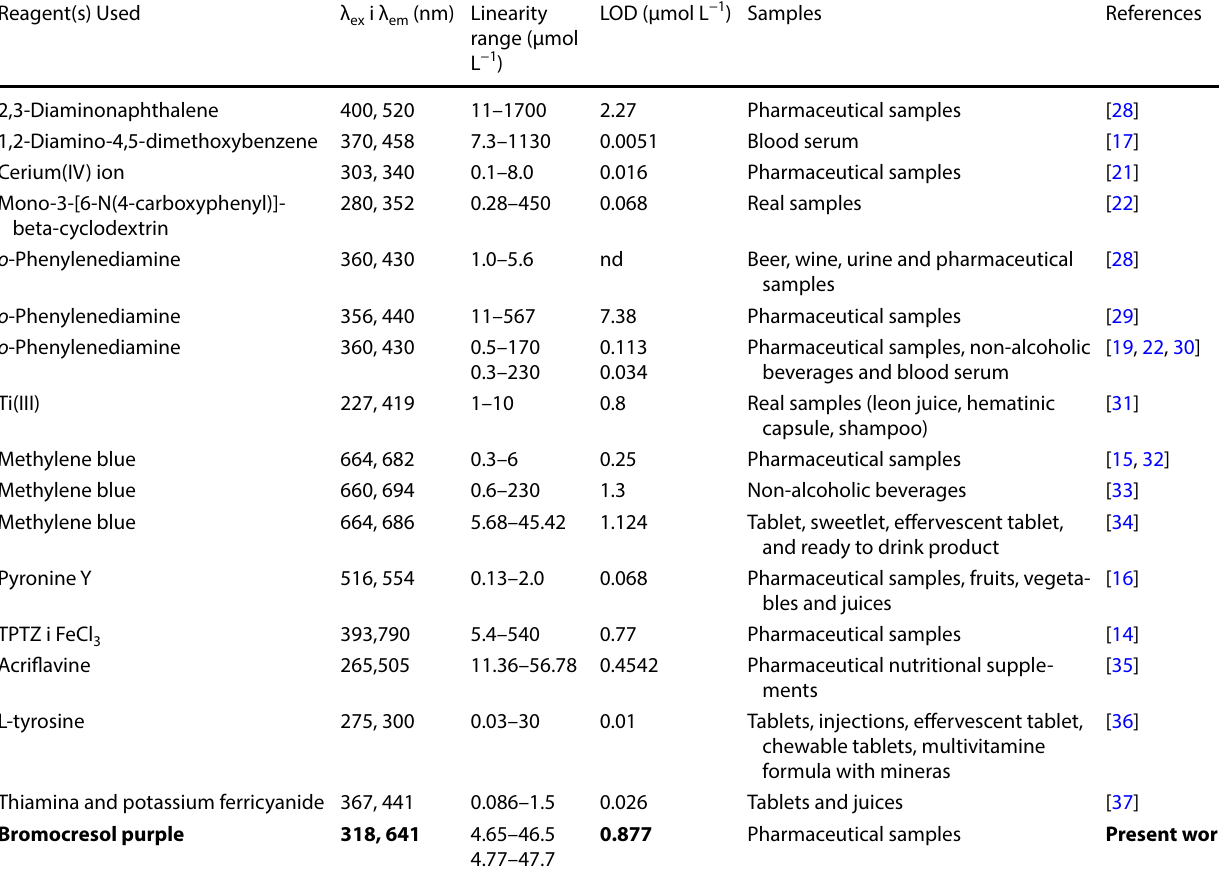
The bold values represent the characteristics of the proposed